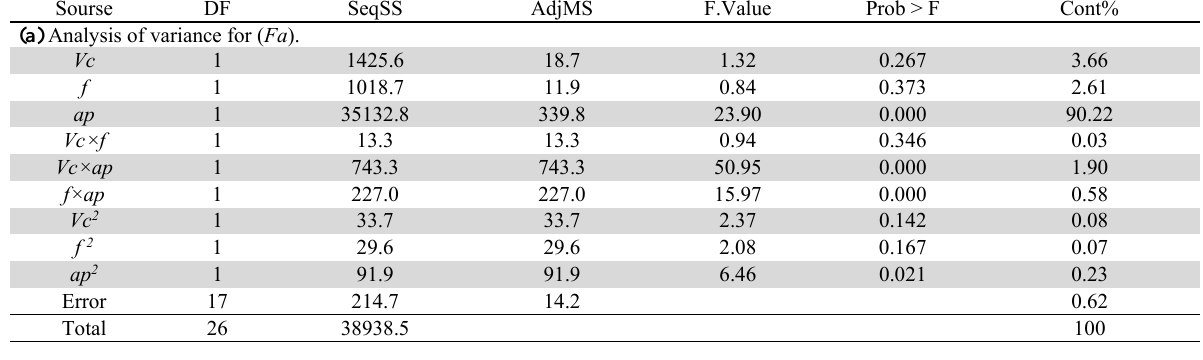
Analysis of variance for cutting force components: (a) Fa , (b) Fr and (c) Ft . Sourse DF SeqSS